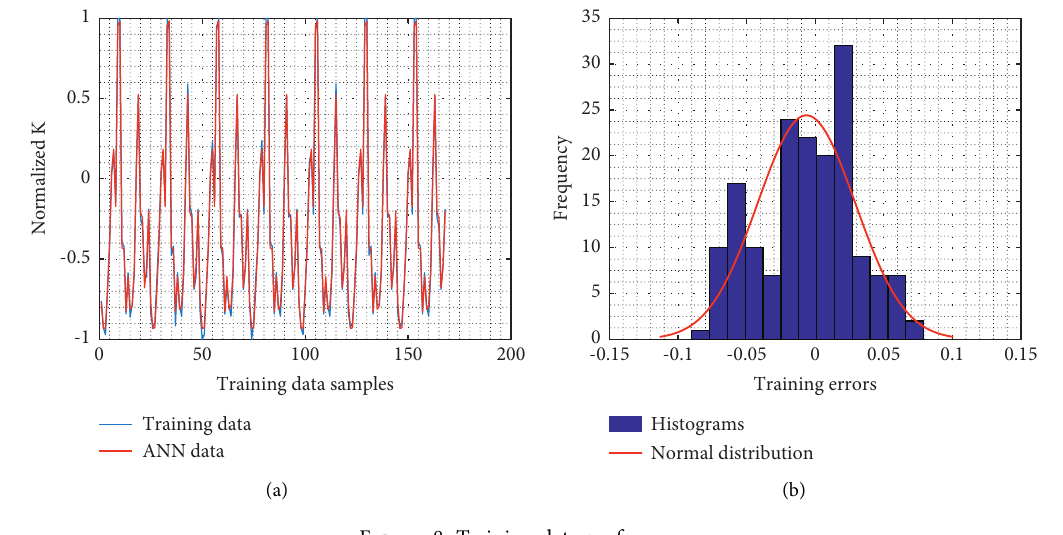
Figure 8: Training data performance.